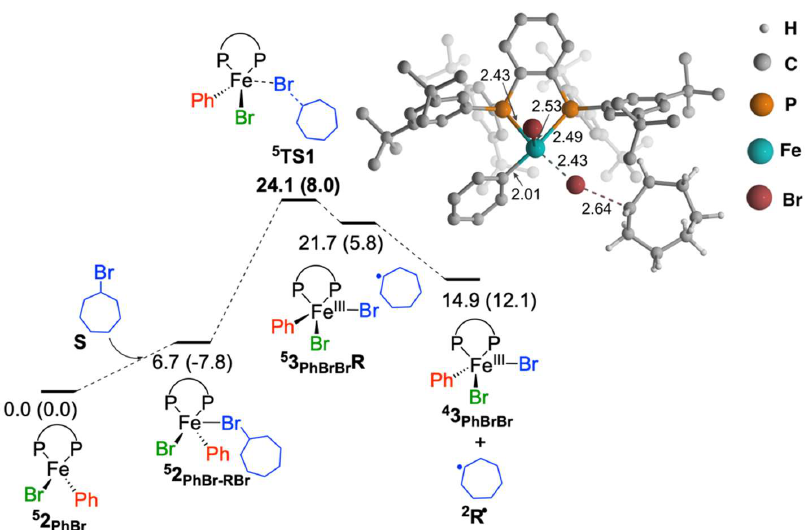
Figure 2. Free energy profile for the reaction of iron(II) species with bromocycloheptane. The relative free energies with respect to 5 2 PhBr and bromocycloheptane are given in kcal / mol with total electronic energies including ZPE (zero-point energy) correction ( ∆ E ZPE ) are given in